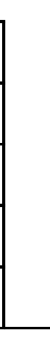
Figure 2. Scatter plot of the differences of volumes in MRI (VolMR) and US (VolUS). The line indicates the median difference. Figure 3. Scatter plot of the Dice coefficients. The line represents the median Dice coefficient of 0.75.